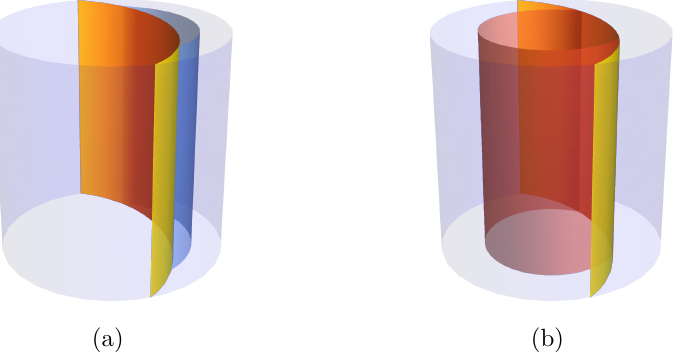
Figure 3. Classical string solutions for static open strings attached to an AdS 2 brane. The string can stretch on either (a) the convex side, or (b) the concave side, of the brane.